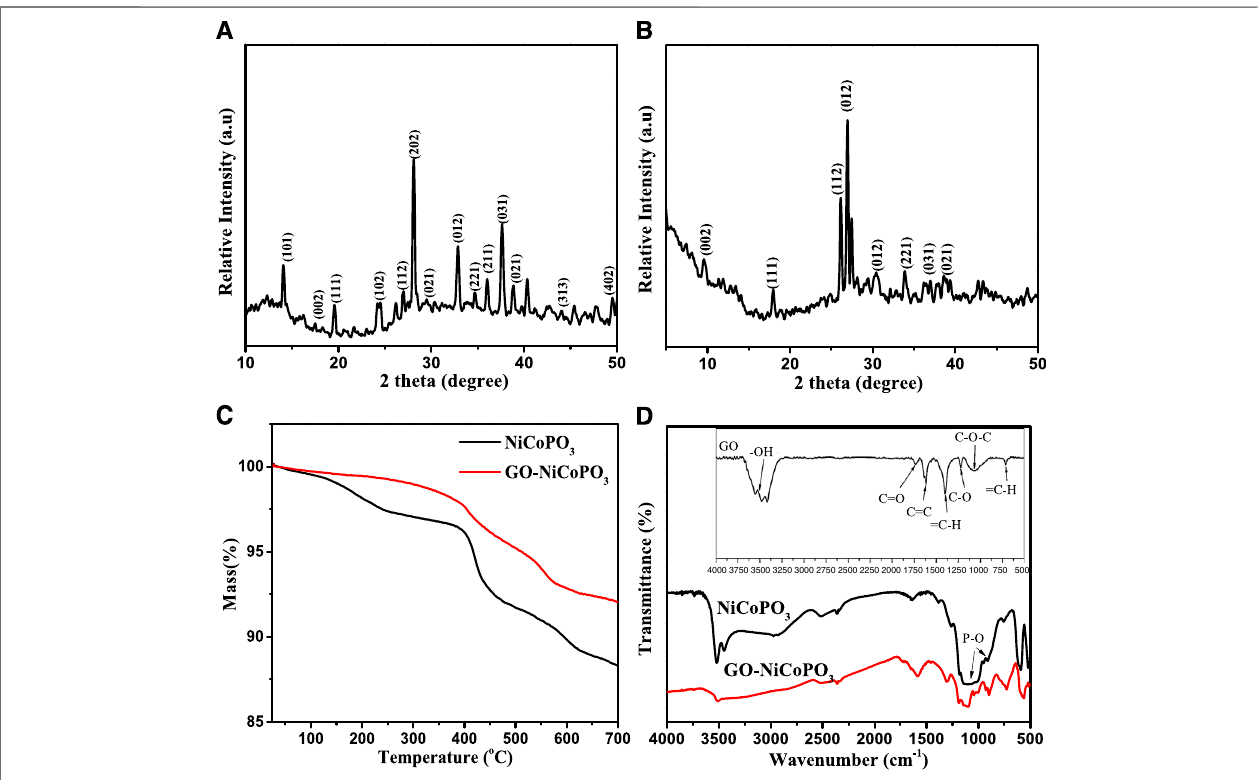
FIGURE 1 | (A) X-ray powder diffraction pattern of NiCoPO 3 ; (B) X-ray powder diffraction pattern of GO-NiCoPO 3 ; (C) TG curves of NiCoPO 3 and GO-NiCoPO 3 ; (D) FouriertransforminfraredspectraspectraofNiCoPO